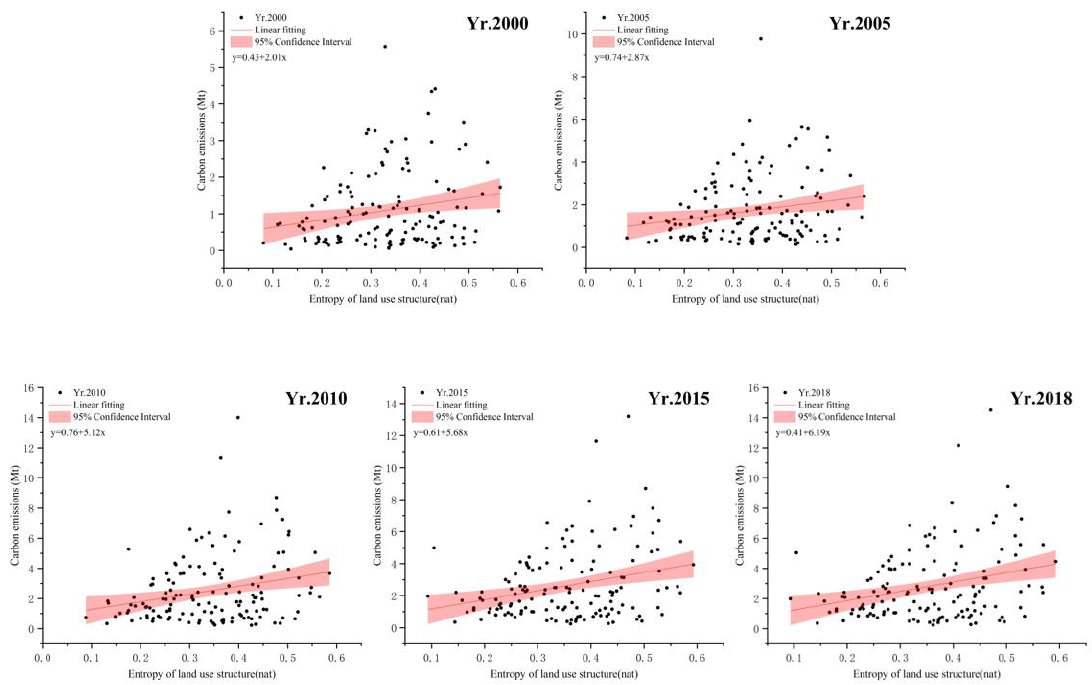
Figure 7. The 2000 − 2018 entropy with carbon emissions Scatter Plot.